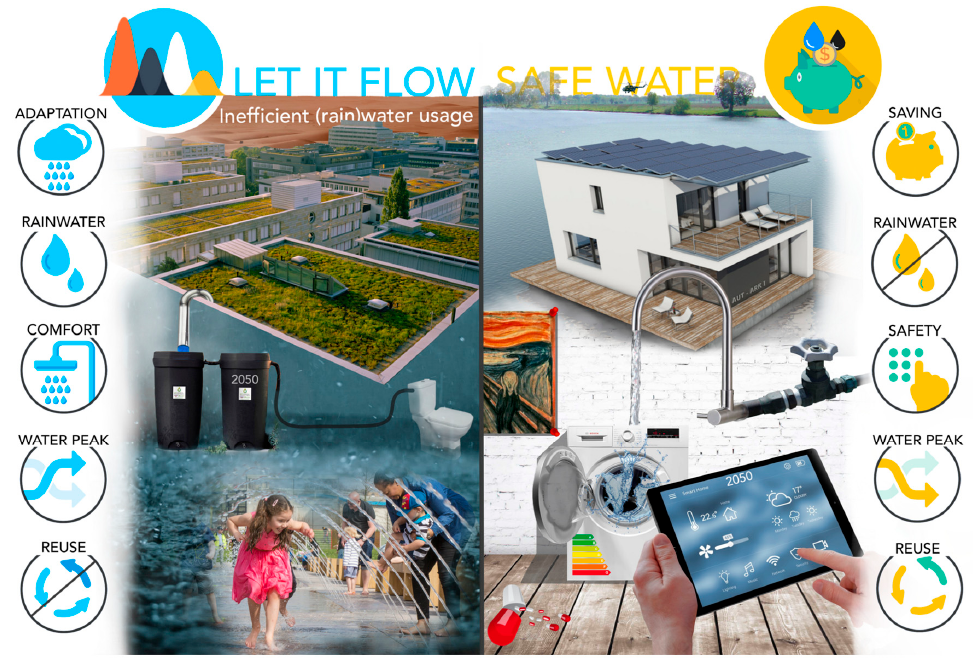
Figure 3. Illustration of the socio-technical scenarios: Let it Flow ( left ) and Safe Water ( right ).